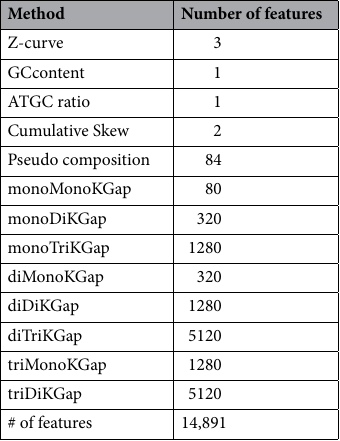
Table 3. PyFeat feature generation and their